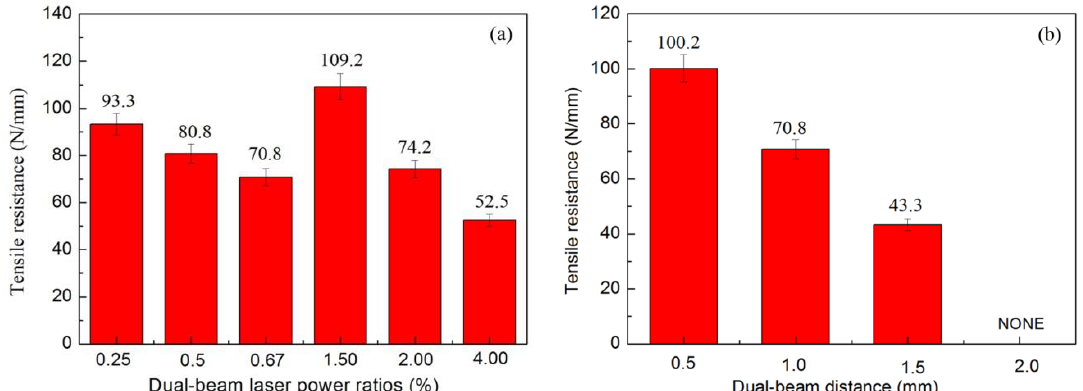
Figure 10. Effect of processing parameters on tensile resistance of the steel/Al joints produced by dual-beam laser welding with side-by-side configuration: ( a ) Rs varied from 0.25 to 4.00; ( b ) d 1 varied from 0.5 mm to 2.0 mm.